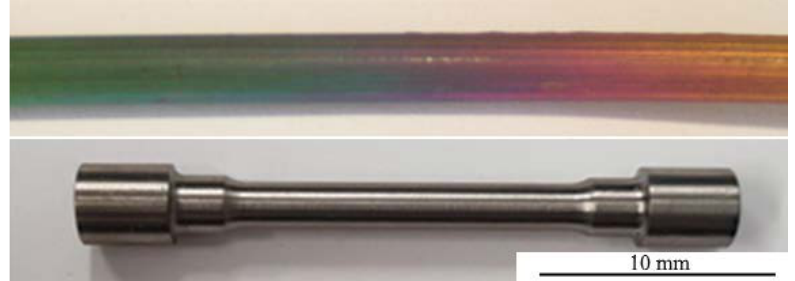
Figure 7. Photographs (at the same magnification) of as-extruded Ti-6Al-4V wire derived from GA powder with multicoloured oxide film ( top ) and a sub-size tensile specimen with 15.00 mm gauge length ( bottom ), tested according to ASTM E8/E8M-15a.